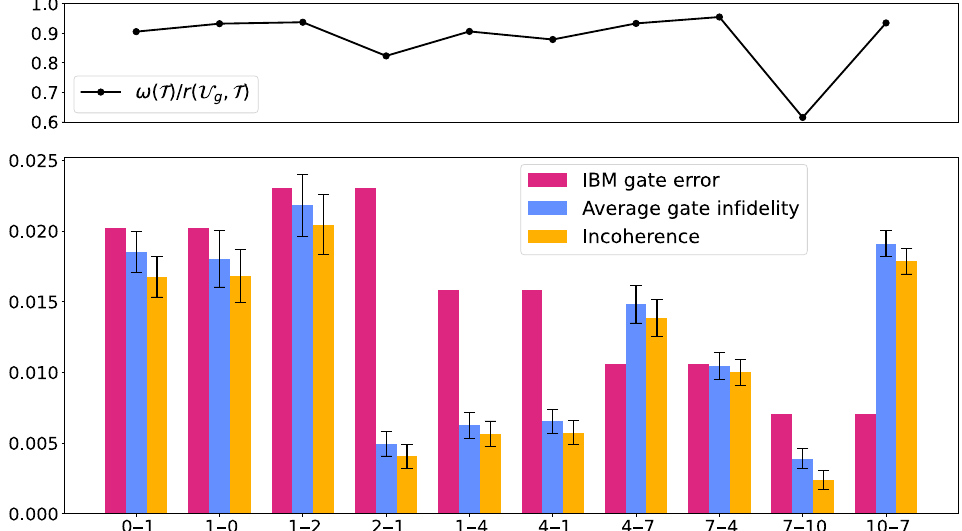
FIG. 3. The error analysis of the set of CNOT gates in IBMQ_GUADALUPE employed for the simulation of the first set of results in Fig. 2. The tick 0–1 on the x axis corresponds to the CNOT gate, where “qubit 0” in IBMQ_GUADALUPE is the control qubit and “qubit 1” is the target. The lower plot shows the gate error provided by IBM (magenta), the experimental average gate infidelity r ( U g , T ) via full process tomography (light blue), and the experimental incoherence ω( T ) (yellow), as defined in Eq. (9). The error bars on the values of r ( U g , T ) and ω( T ) are the standard deviations of 100 realizations of a random sample of the experimental data via bootstrapping. The upper plot shows the ratio between the incoherence and the experimental average gate infidelity of each CNOT